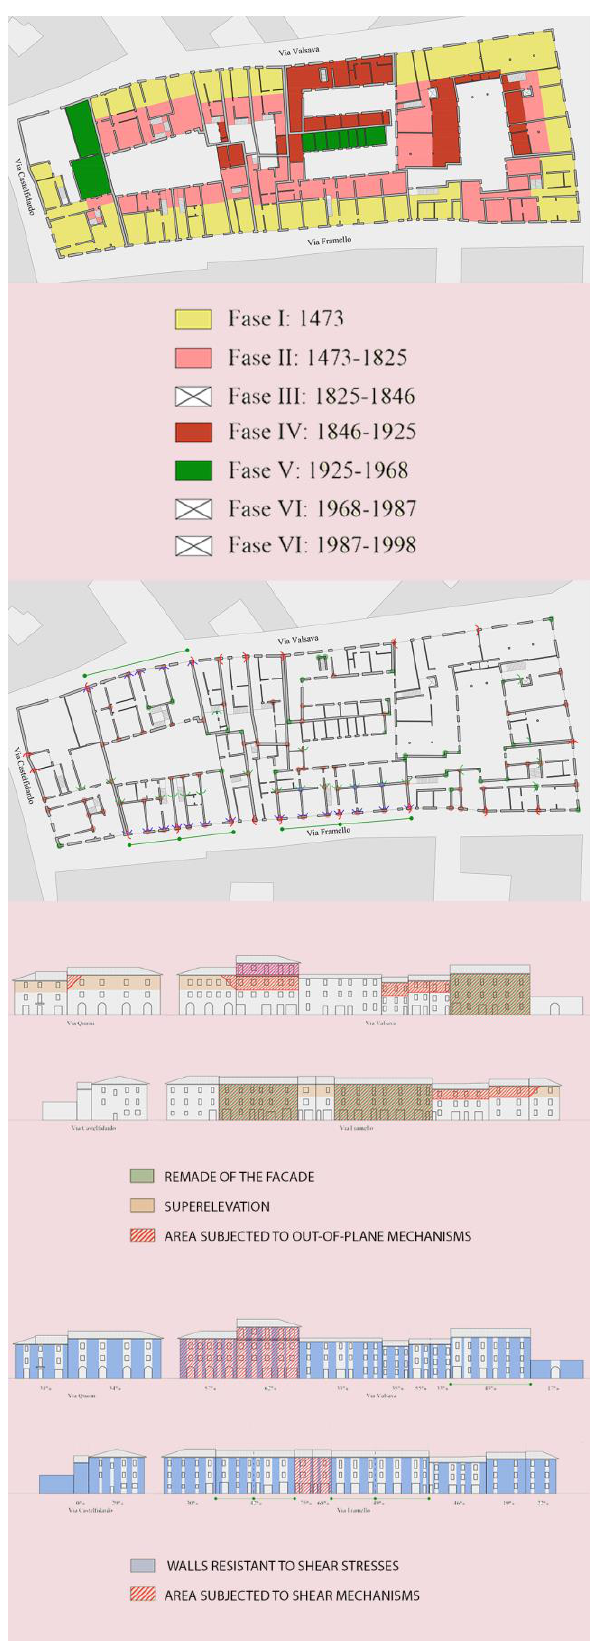
Figure 3. Indicators used for the seismic assessment Summary of the seismic vulnerability assessment for one of the analyzed building aggregates; from top to bottom: historical